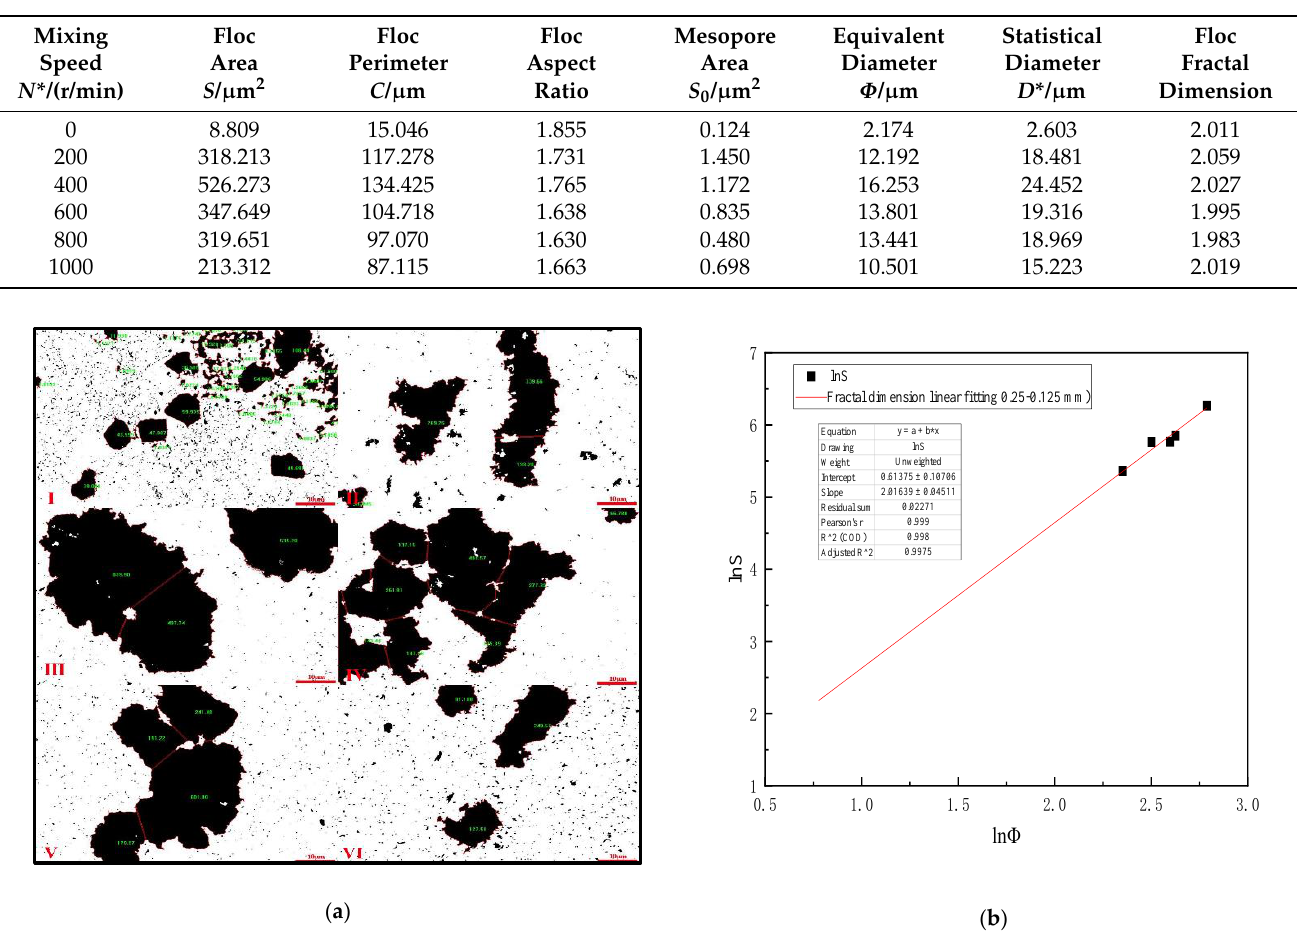
Figure 8. ( a ) Area diagram of 0.25–0.125 mm coal slime floc at different mixing speeds. ( I ) 0, ( II ) 200 r/min, ( III ) 400 r/min, ( IV ) 600 r/min, ( V ) 800 r/min, ( VI ) 1000 r/min; ( b ) Fractal dimension fitting diagram of settling floc of 0.25–0.125 mm coal slime. Table 8 is analyzed by Image-Pro-Plus 6.0 software and (Formulas (15)–(17)), which shows that when the mixing speed is 200 r/min, the equivalent diameter of 0.125–0.075 mm slime settling floc is the largest, and the settling speed of slime floc is the fastest on the microscopic level. Figure 9a is the analysis diagram of floc area of 0.125–0.075 mm slime at the mixing speed of 0–1000 r/min. Figure 9b shows the fractal dimension fitting diagram, when the mixing speed is 0–1000 r/min, the mean fractal dimension of 0.125–0.075 mm coal slime floc is 2.099.